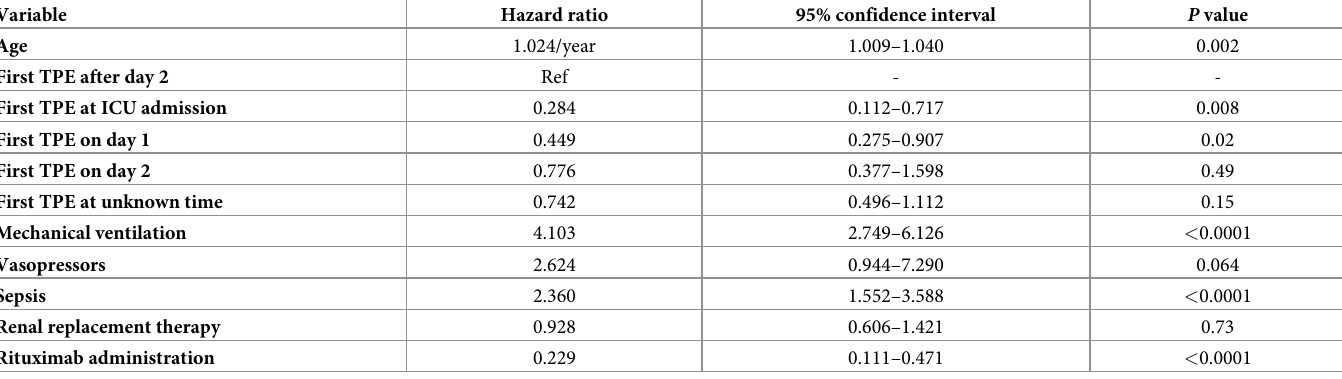
Table 3. Results of the Cox mixed-effects model analyzing mortality in patients with thrombotic thrombocytopenic purpura treated with therapeutic plasma exchange. Variable